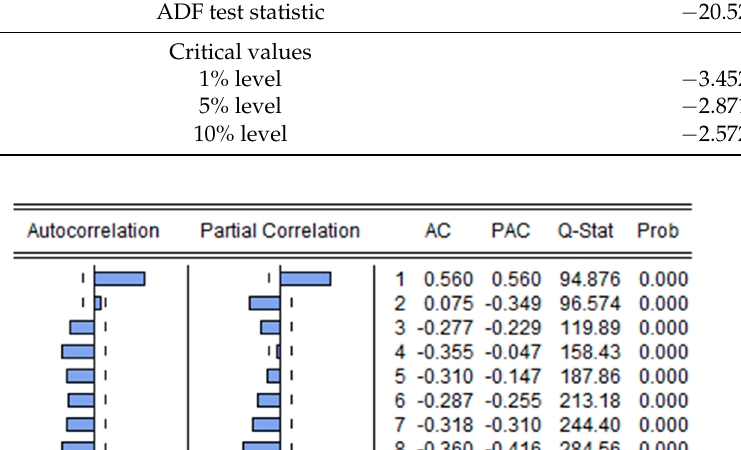
Table 2. The values of unit test of training dataset. Null Hypothesis: Temp Is Stationary at First Differenced ADF test statistic